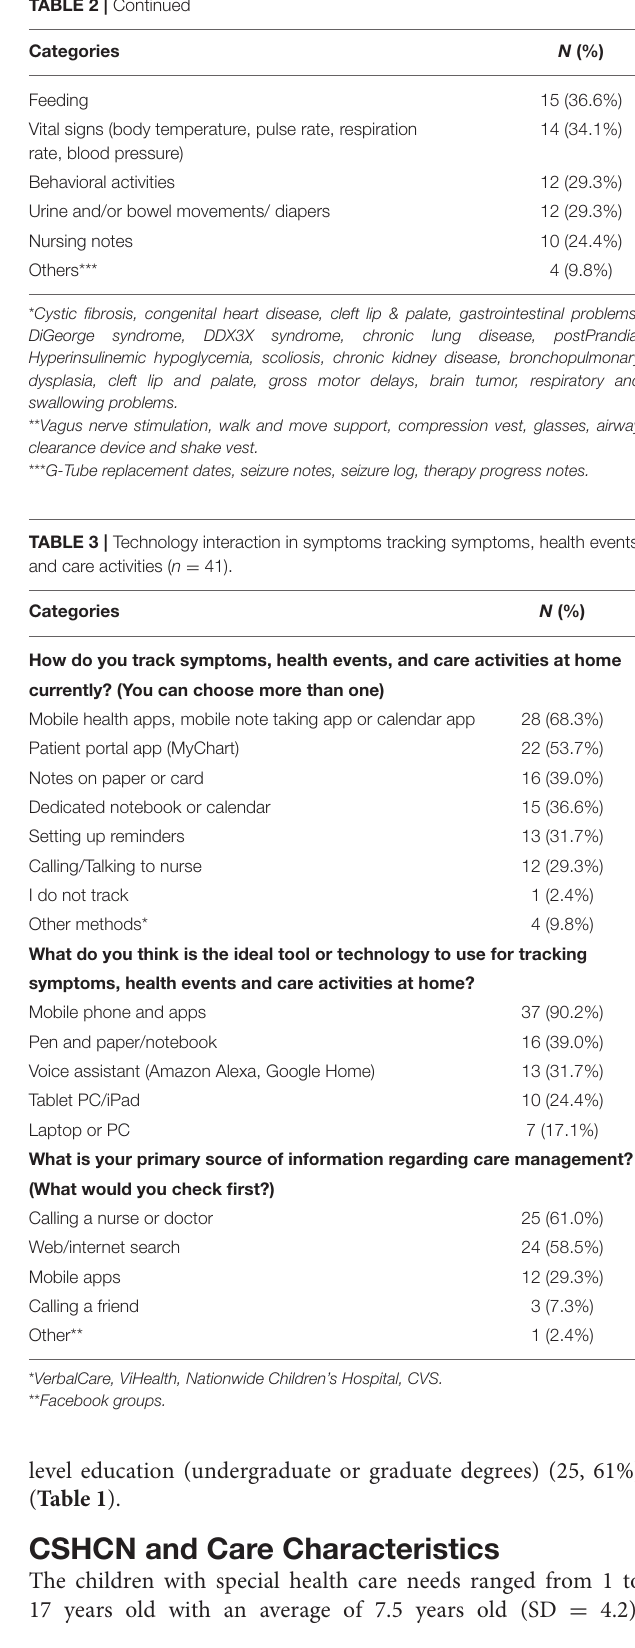
TABLE 2 | Child conditions, treatment, and symptom tracking ( n = 41).